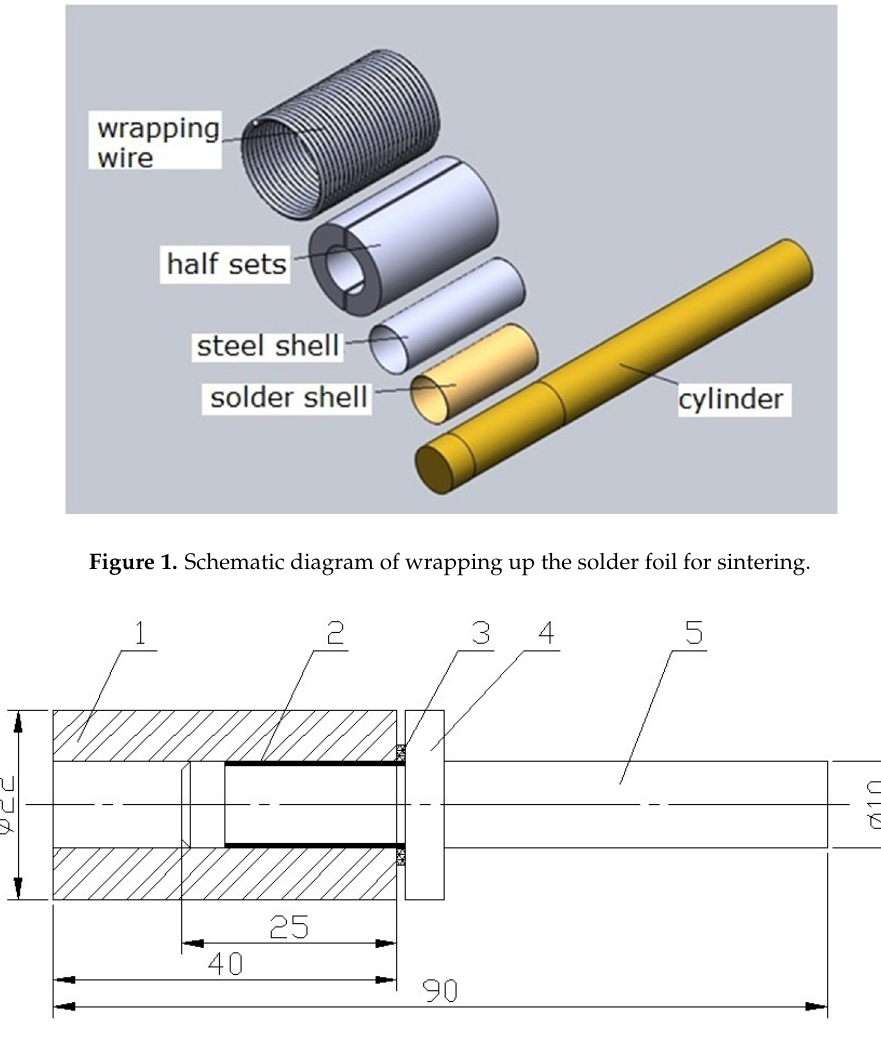
Figure 2. Schematic diagram for brazing of the cylinder and the sleeve with side melt feeding. 1—sleeve, 2—brazed solder, 3—solder for side melt feeding, 4—graphite, 5—cylinder. Dimensions in mm.